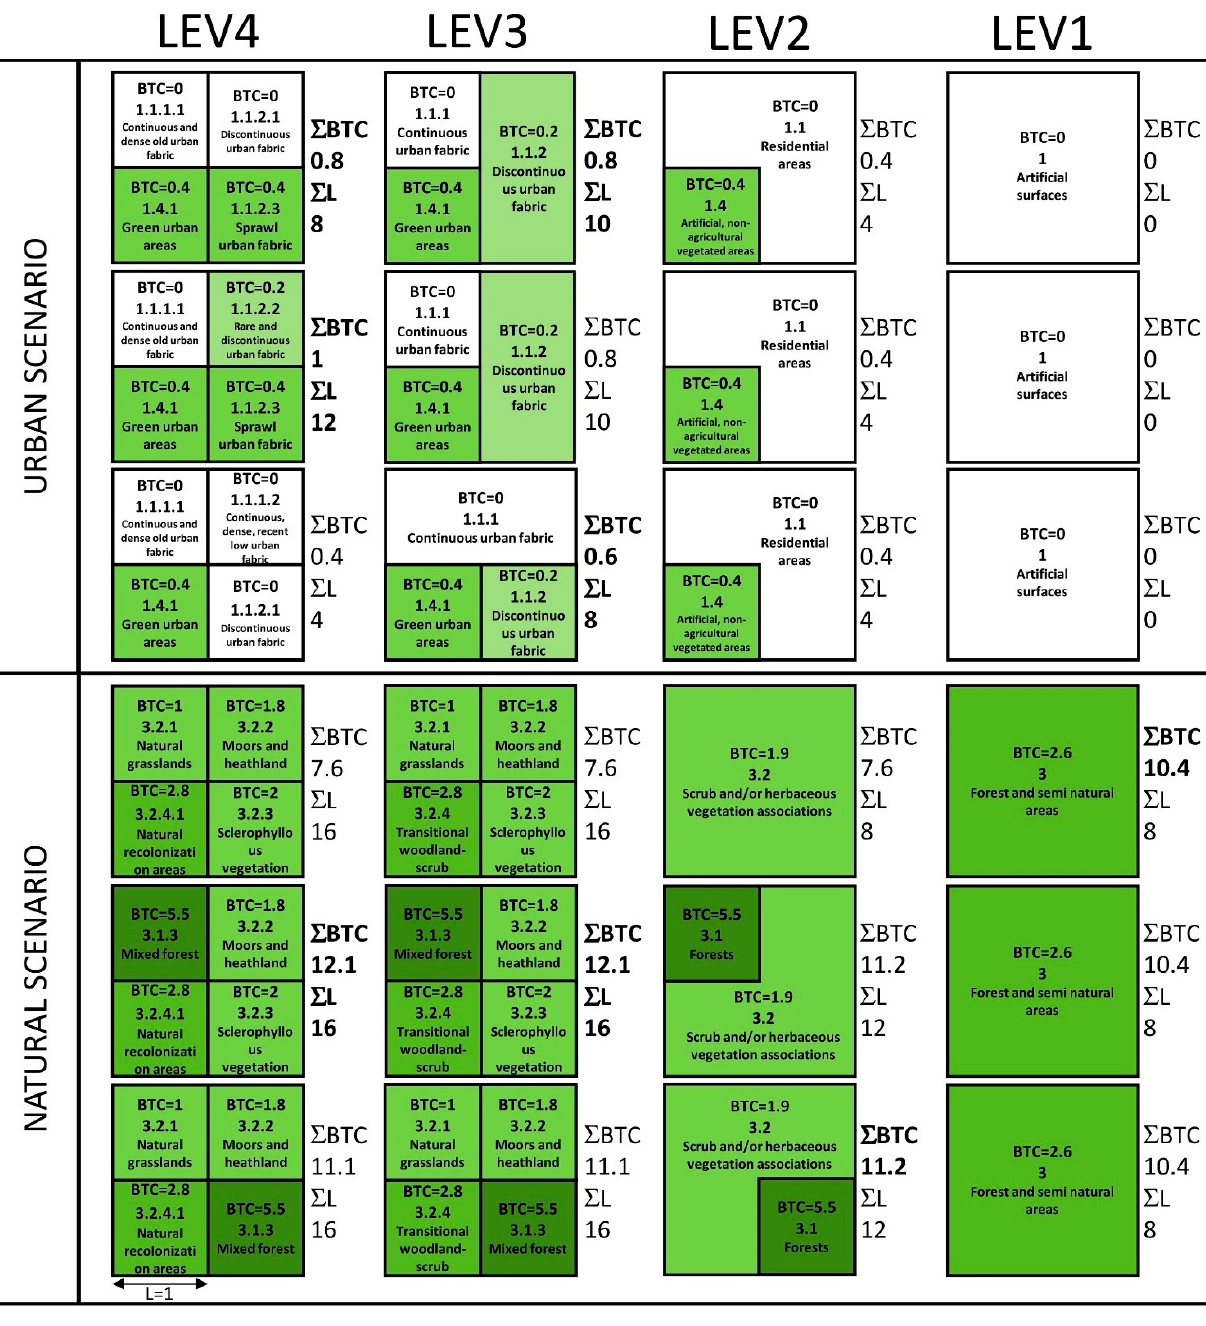
Figure 1. Simplified landscape units representing six patterns of land cover across the four CORINE classification levels. Values represent the Biological Territorial Capacity (BTC value associated with each land cover (LC) (see Table A1, Appendix A). Green scale refers to BTC values of patches, with darker colors signifying higher ecological value. L represents the perimeter, i.e., the ecotonal zone of the LC patch with a BTC > 0. Higher values of Σ L describe more landscape diversity and the possibility of bio-energy exchange. Bold characters indicate higher total BTC and L values for each scenario.